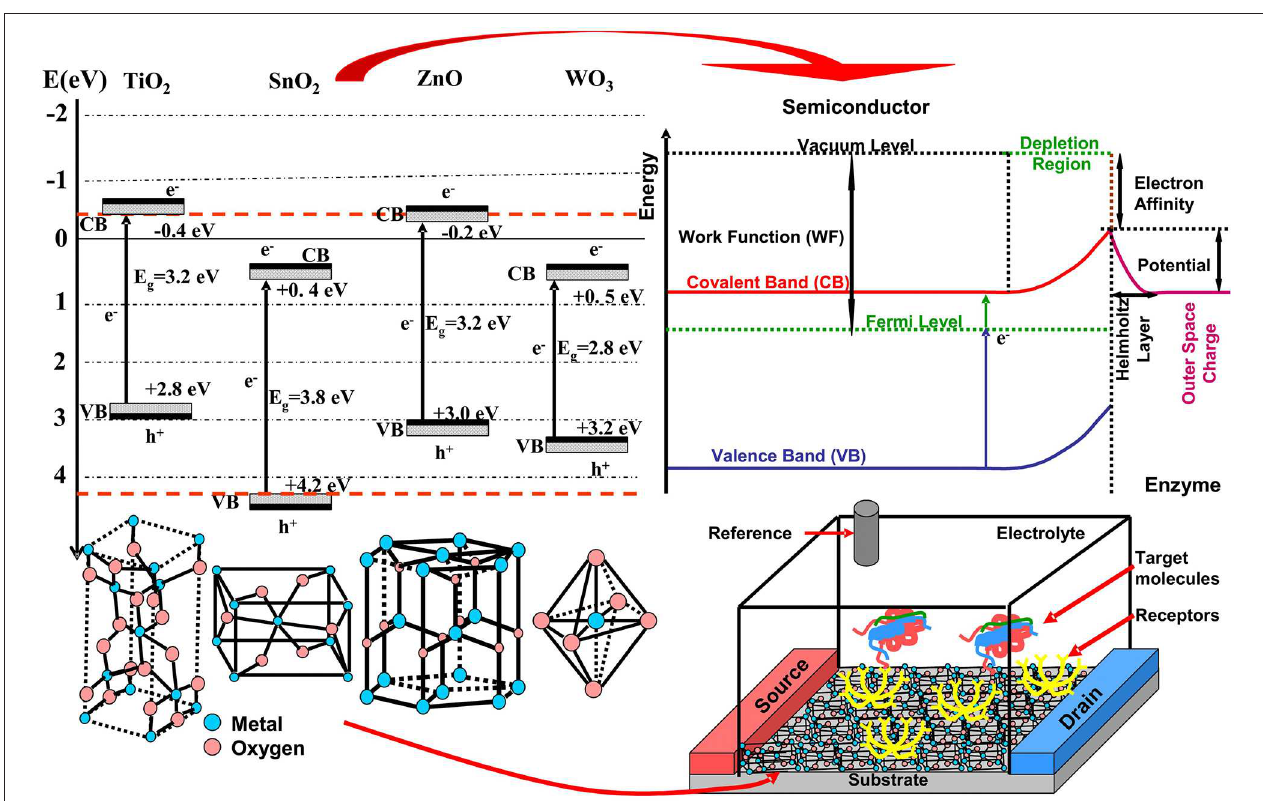
FIGURE 1 | MOS used in biosensors: band energies, crystalline structure, and biosensor configuration.